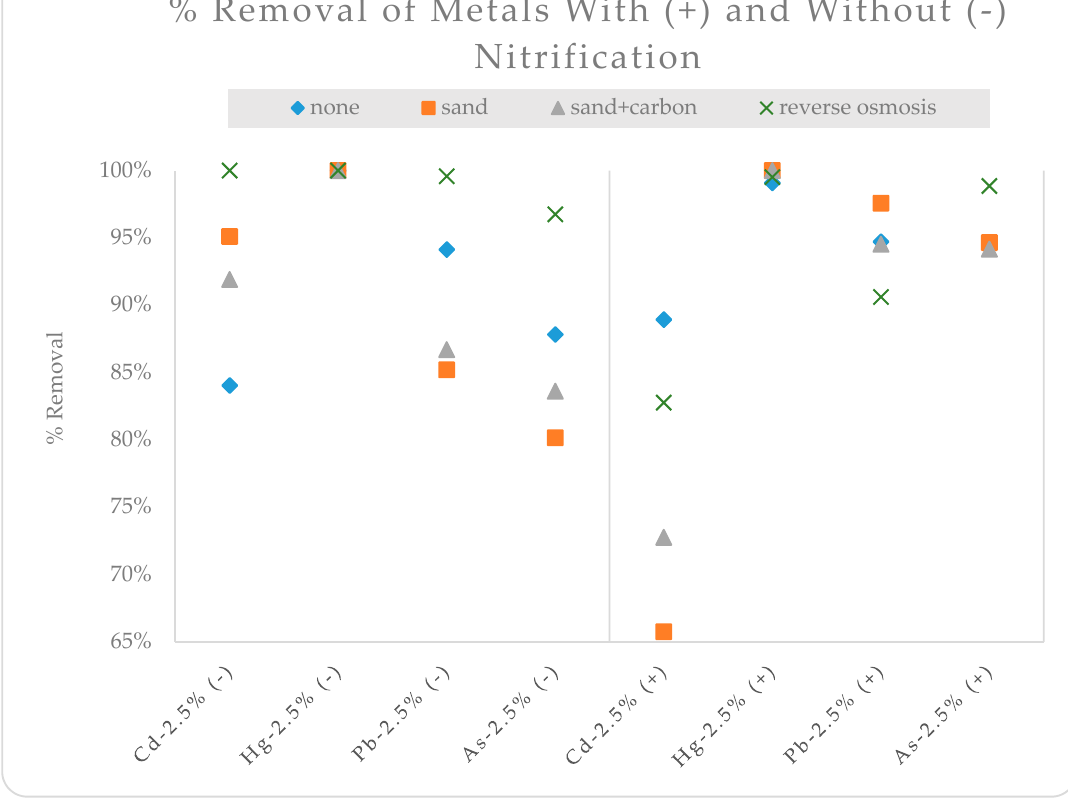
Figure 5. The percent removal of each metal from the four treatments with and without nitrification.